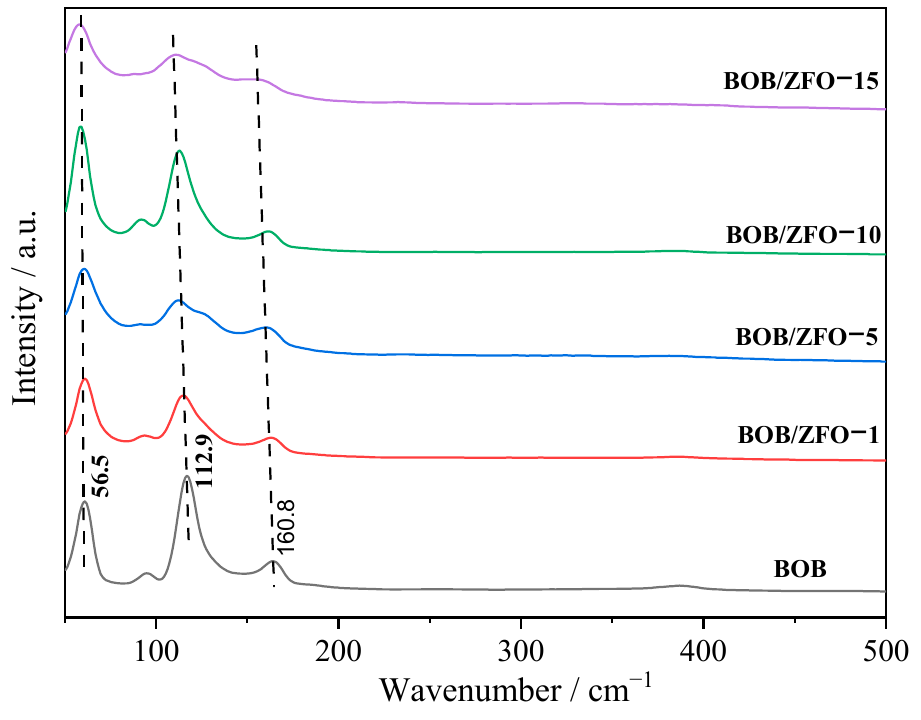
Figure 6. Raman spectra of the synthetic samples.